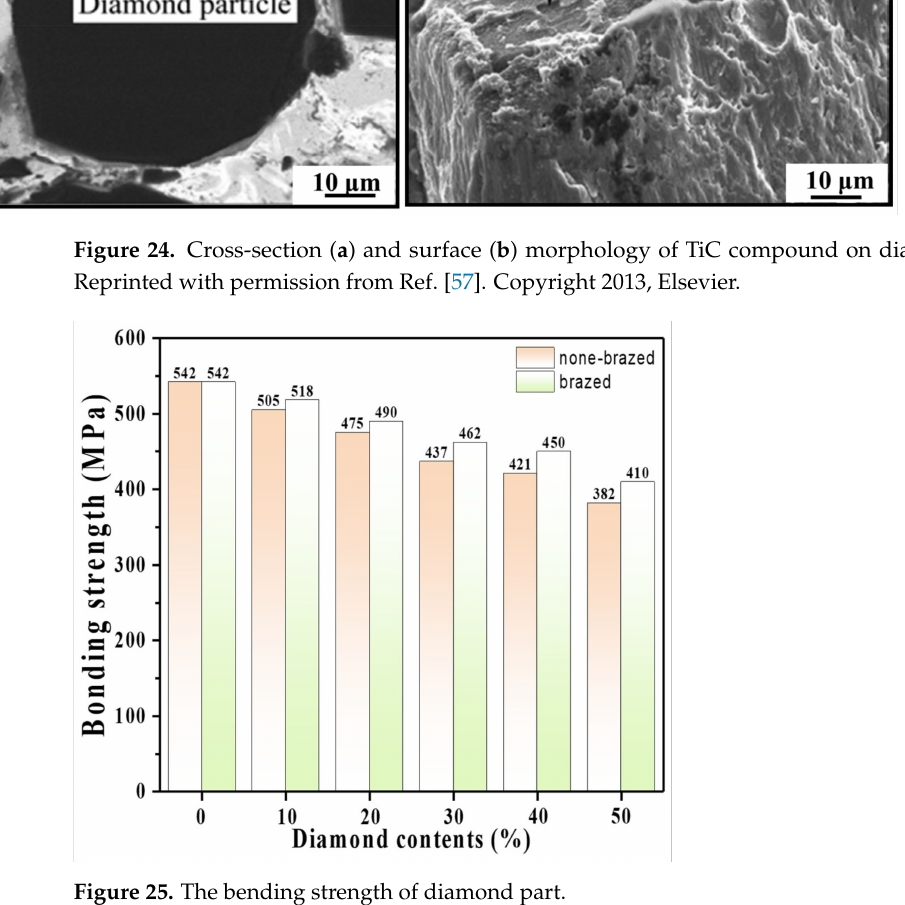
Figure 25. The bending strength of diamond part.